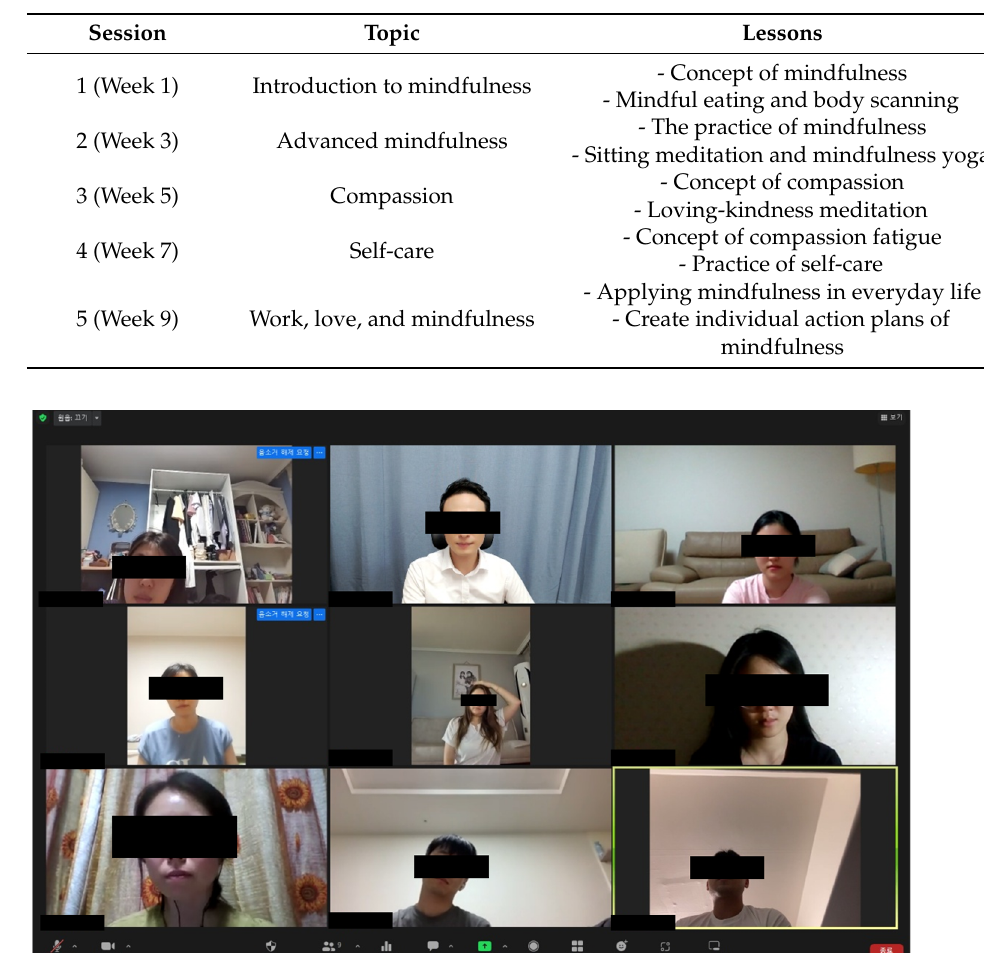
Figure 1. A screenshot of the online mindfulness program via Zoom meeting (Session 1).